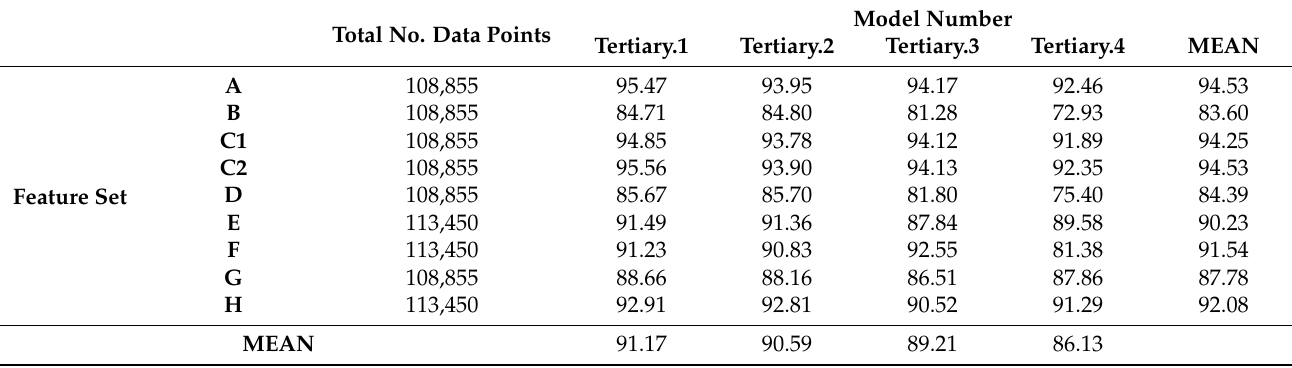
Table 8. A summary of each feature set paired with each model for the binary classification problem, tested using the 70% train, 30% test method. The mean accuracy value for each feature set and model number are also